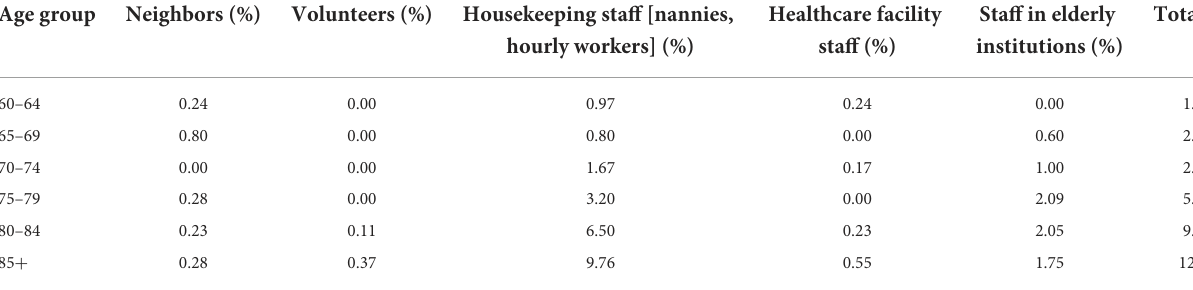
TABLE 9 Proportion of elderly groups in the Yangtze River Delta with community-based care and